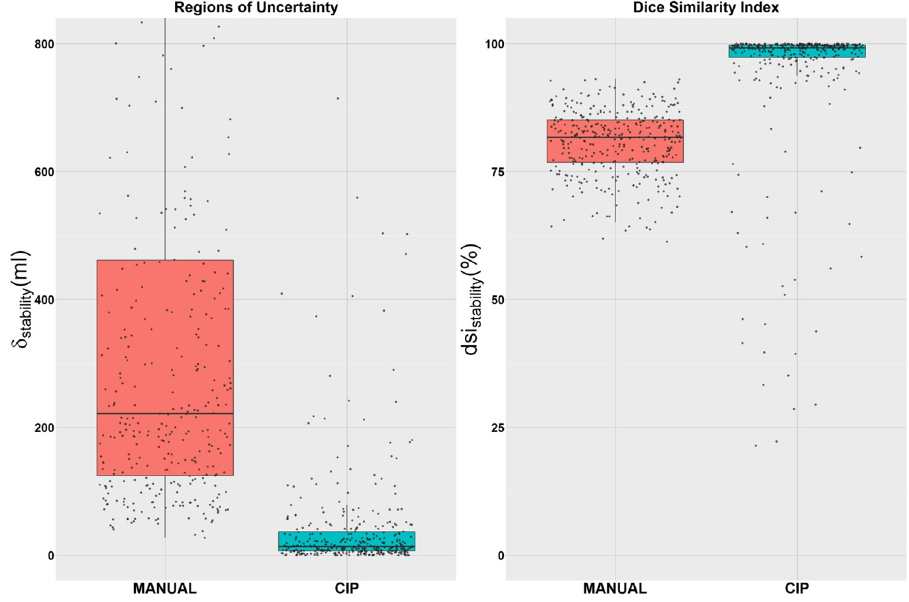
Fig 2. Robustness (or stability) of the manual and CIP-based segmentation. The robustness of the manualand CIP-basedsegmentation assessedwith the regionof uncertainty( δ ) and Dice similarity index